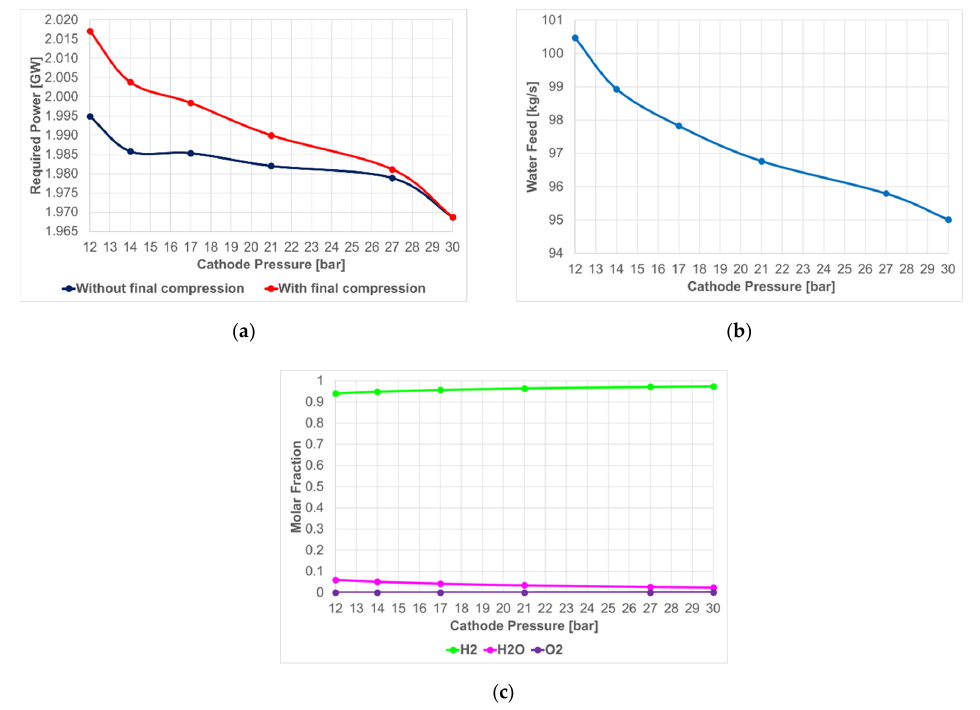
Figure 7. Results related to cathode operating pressure changes for 10 kg/s H 2 production: ( a ) Total required power; ( b ) water feed rate; ( c ) molar fraction in gas flow obtained in cathode section.